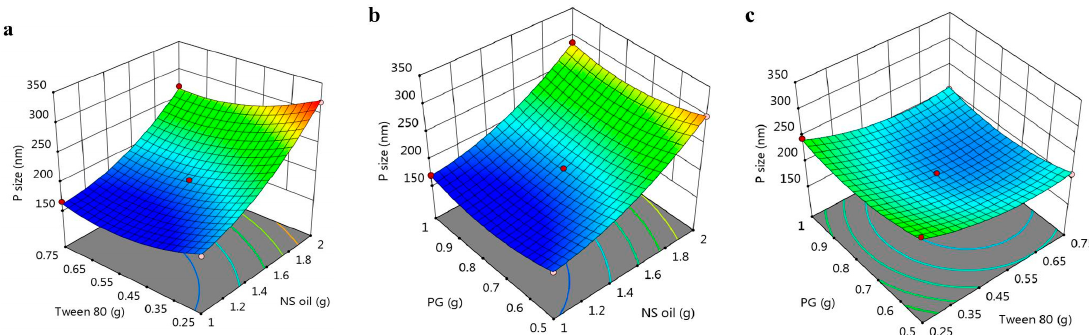
Figure 1. 3D response surface plot representing the effect of independent variables ( a ) NSO and Tween 80, ( b ) NSO and PG, and ( c ) Tween 80 and PG on particle size (R 1 ).